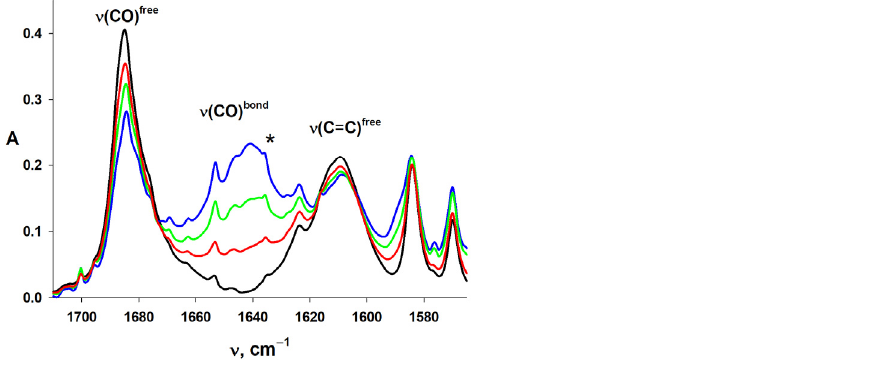
Table 2. 13 C NMR с hemical shifts of E- 1 and Z- 1 in the presence of di ff erent amounts of [AgPz] 3 , CCl 4 /C 6 D 6 ( v / v =9/1), 298 K.